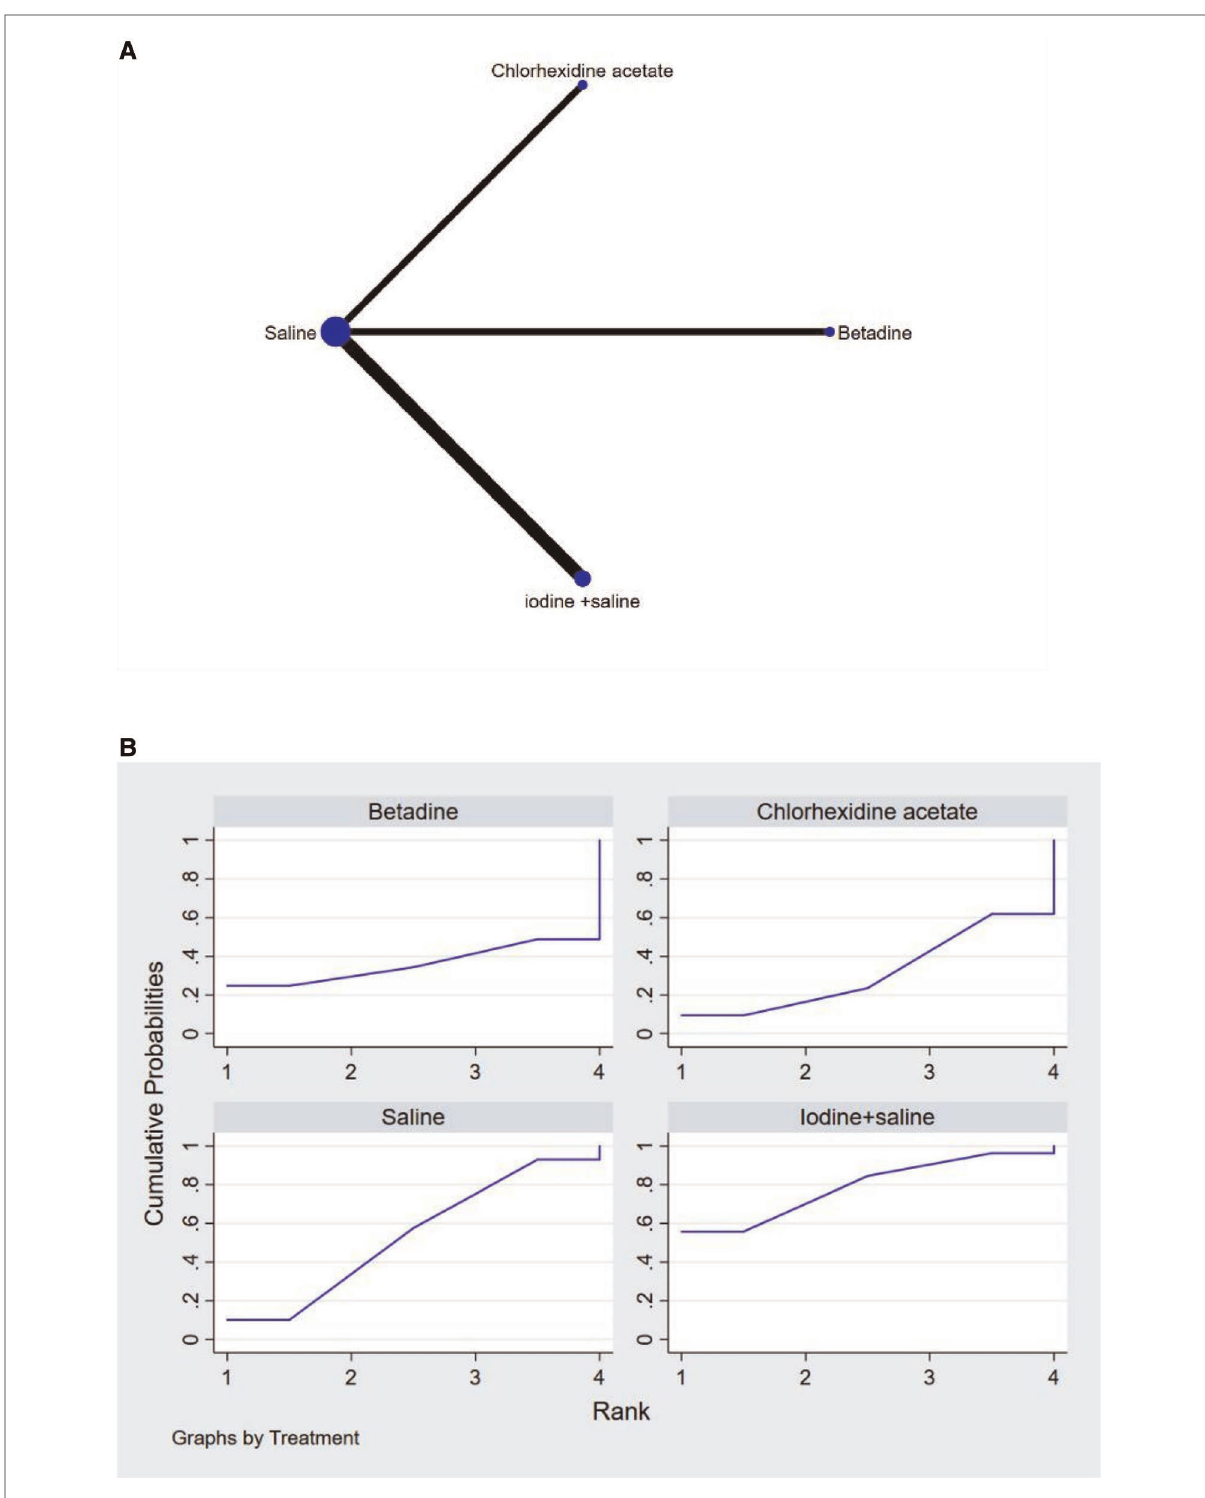
FIGURE 4 ( A ) NMA fi gure for FR ( B ) SUCRA plot for